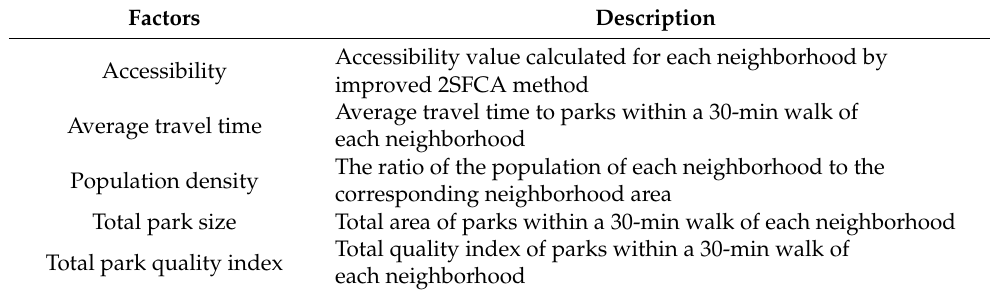
Table 2. Factors involved in